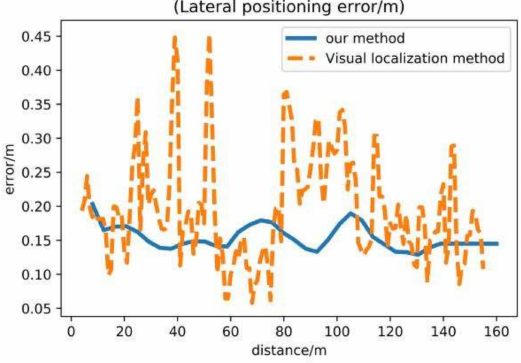
Figure 12. Lateral localization error.